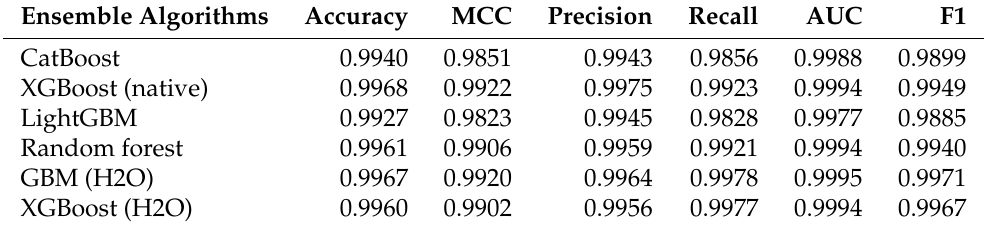
Table 7. Performance average of each ensemble technique over various malware